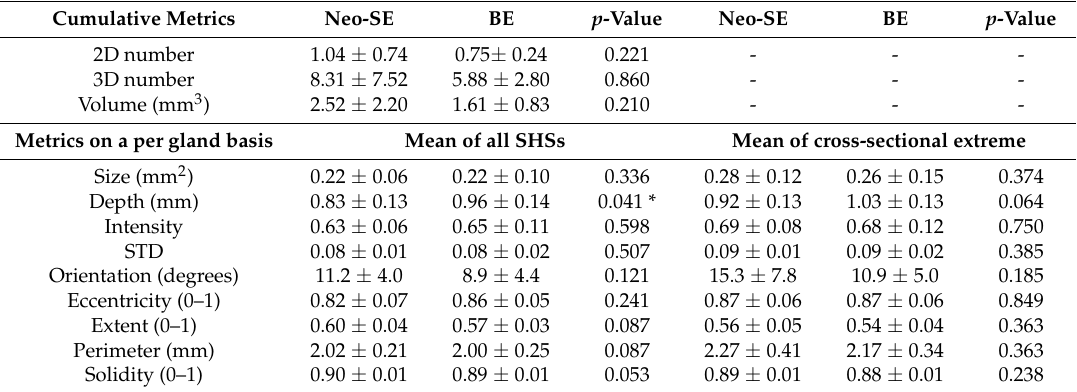
Table 3. Comparison of pre-radiofrequency ablation (RFA) BE SHS between patients who did and did not have RFA treatment response on follow up (achieving neosquamous